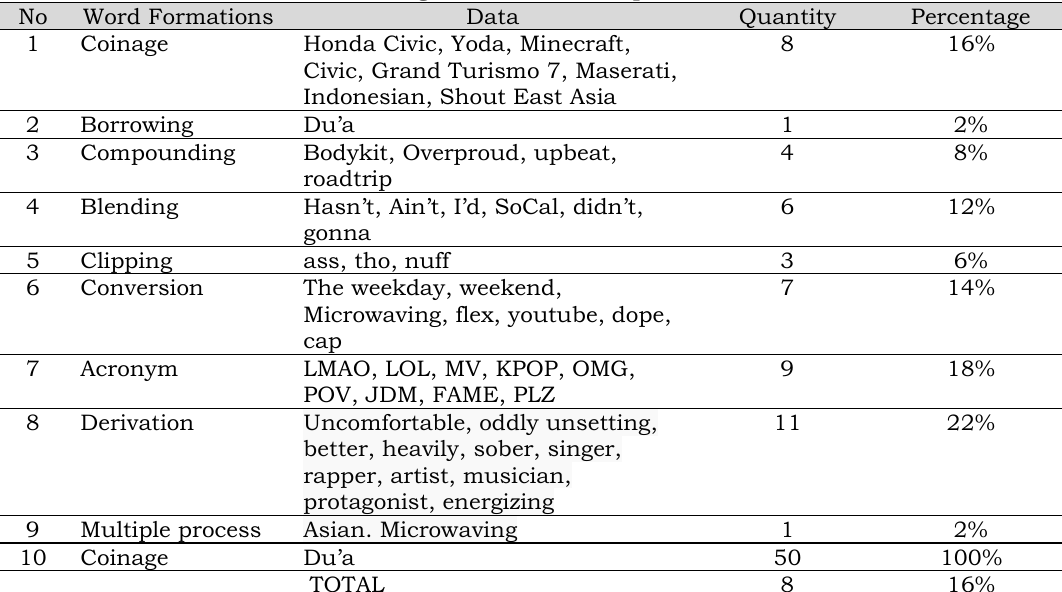
Table 1. Slang word formation process